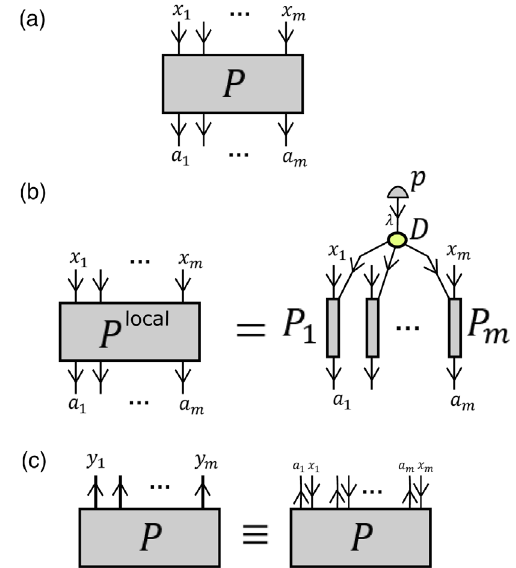
FIG. 4. Boxes as tensors. (a) A nonsignaling box as a tensor P x 1 x 2 ; … ;x m a . (b) A Bell-local box P local decomposes as shown in 1 a 2 ; … ;a m , each of which is a terms of three-index tensors P 1 ; P 2 ; … ; P m conditional probability distribution. Here, D is an m -index identity tensor (also called a copy tensor ), namely, a tensor 1 , and p whose only nonzero components are D λ is a ii; … ;i ¼ vector of probabilities p ð λ Þ . (d) For convenience, we combine ; x each pair ð a of input and output indices of a box into a single k k Þ ≡ ð a ; x outgoing index y k k k Þ